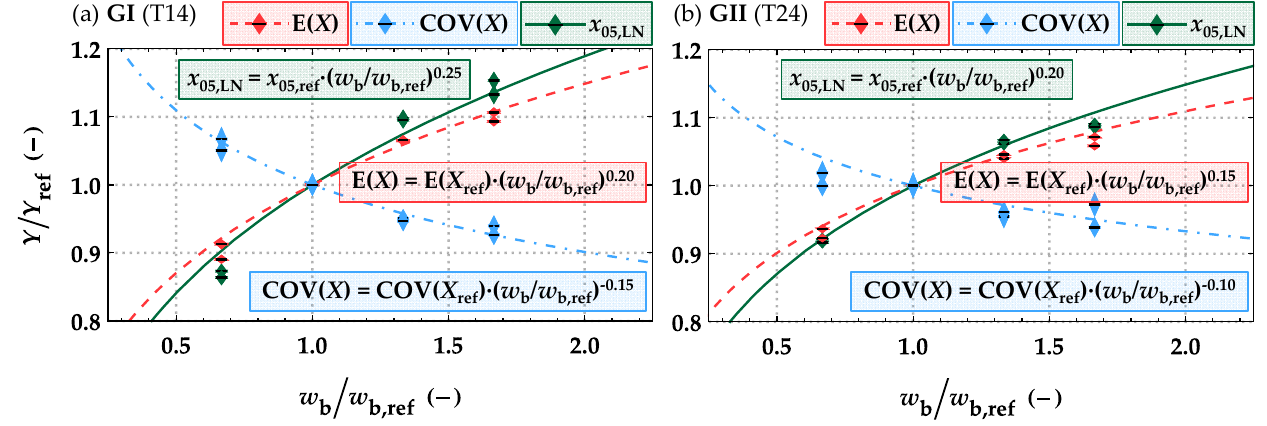
Figure 11. Influence of the width on the main statistics Y = {E( X ); COV( X ); x 05,LN } of the tensile strength parallel to the grain of boards ( X = f t,0,b ) featuring a length of l b = {2.0; 4.0} m relative to the statistics at a reference width of w b,ref = 150 mm and l b,ref = {2.0; 4.0} m; analysis based on virtually generated boards for GI ( a ) and GII ( b ).